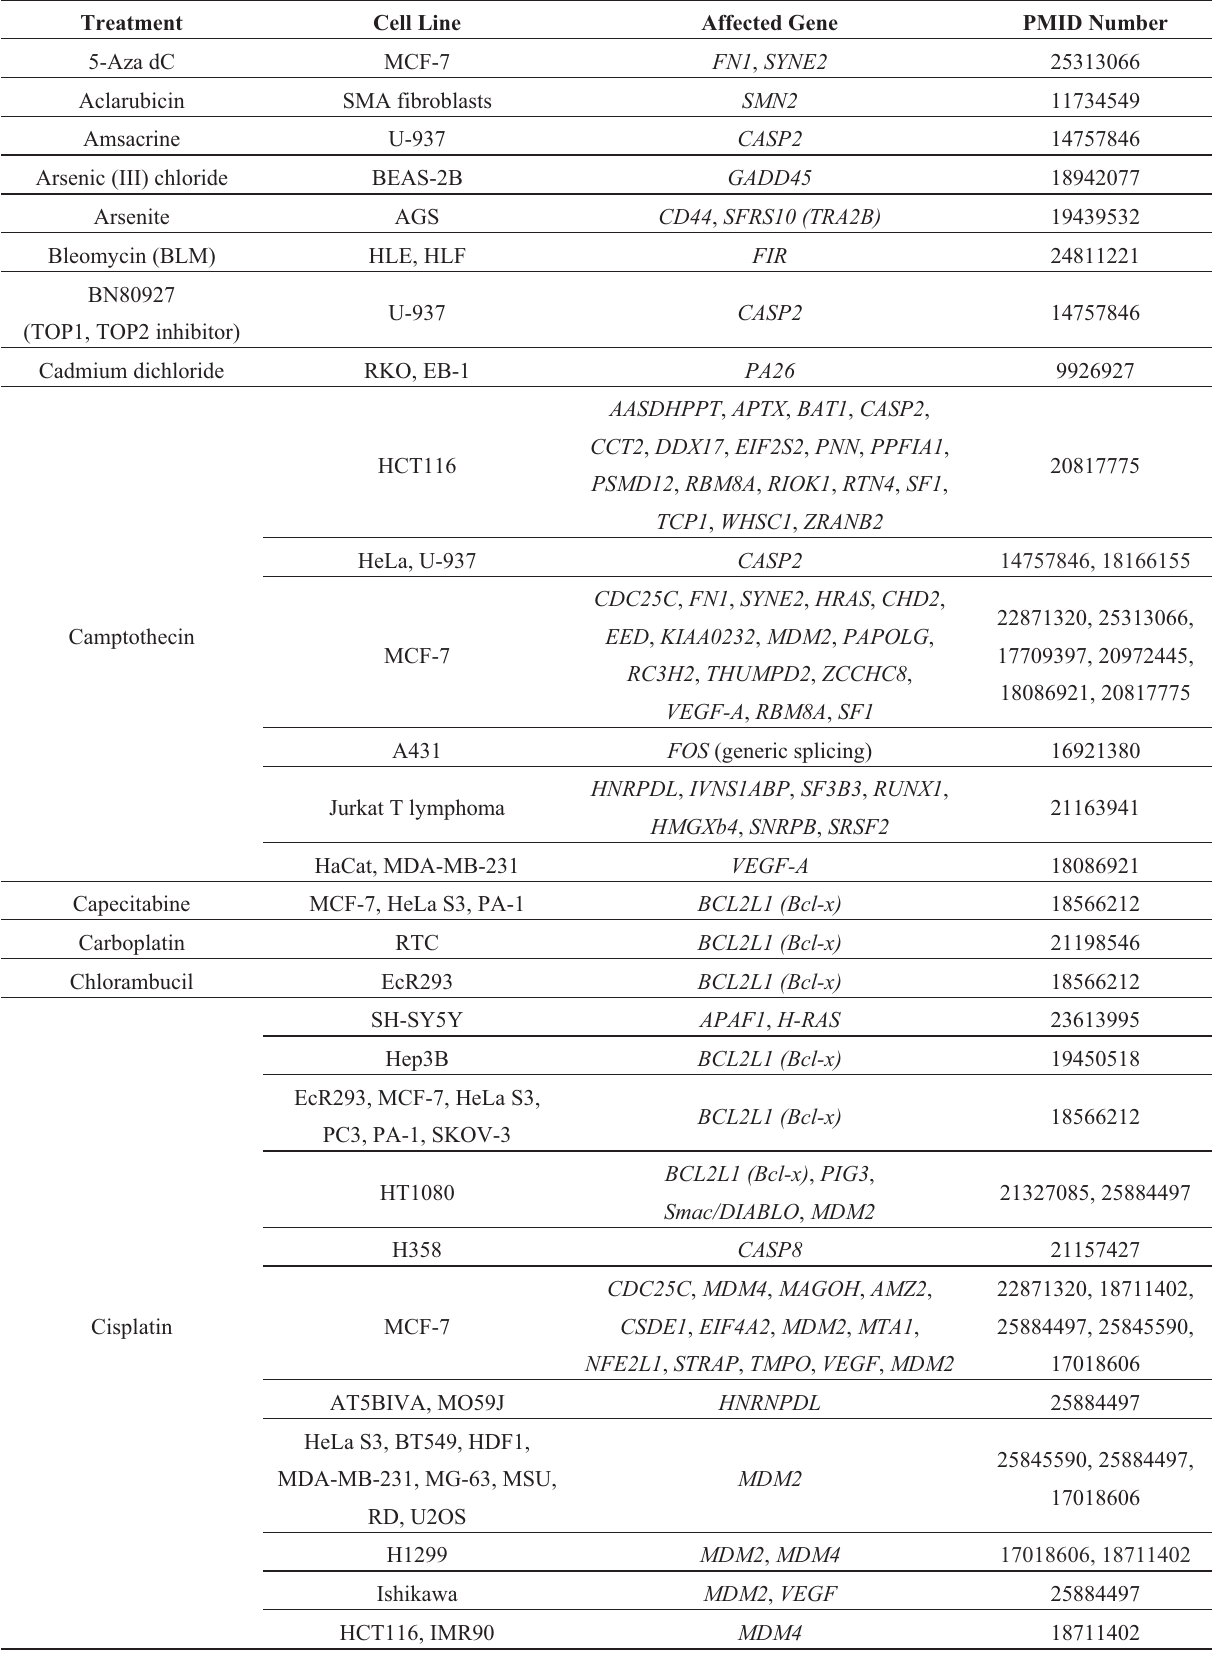
Table 1. Alternative splicing events validated by RT-PCR that are affected by DNA damaging agents. The reference for each study is provided as a PubMed Identification (PMID)